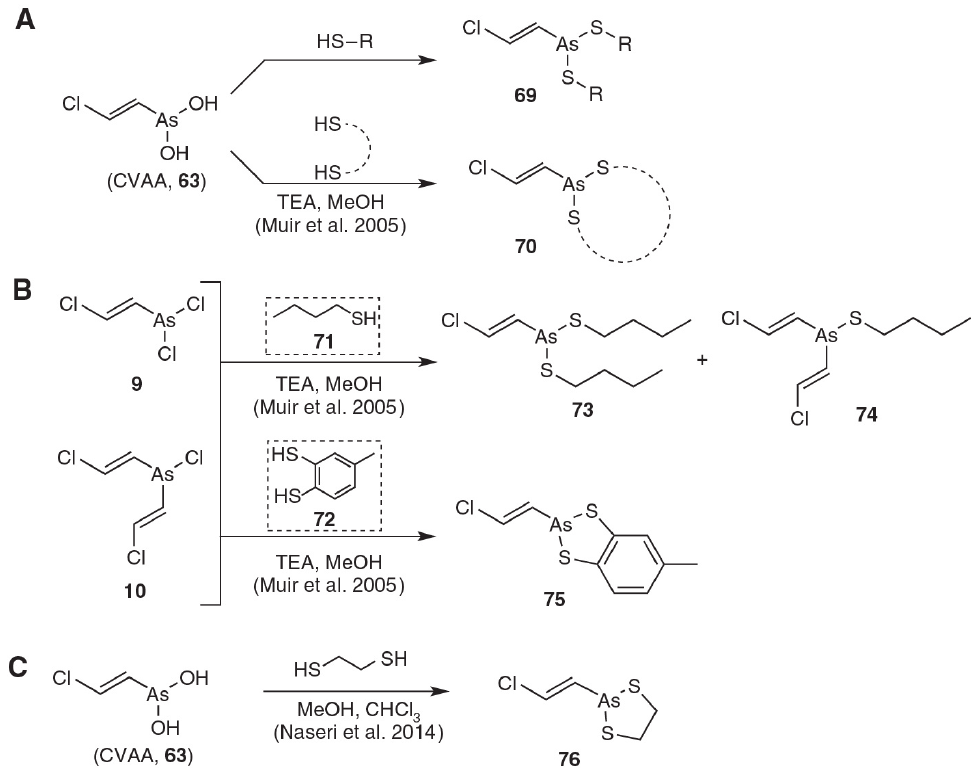
Figure 13: Derivatization of Lewisites I and II using thiol-based